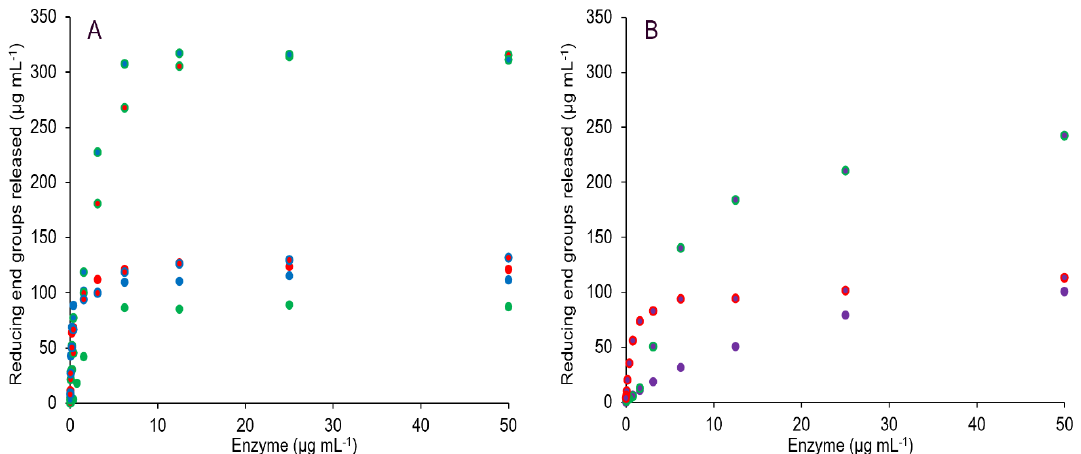
Figure 12. Reducing end groups released from AX (1 mg mL − 1 ) shows synergy after 1 h incubation with ( A ) Hi ABF43_36a (green), Mg ABF51 (red), Po ABF62 (blue), and their combined activities, and ( B ) Tp ABF43_36b separately (purple) and together with Mg ABF51 (red) and Hi ABF43_36a (green). Reaction conditions are displayed in Section 4.2.2, exp. # 3 and 4.